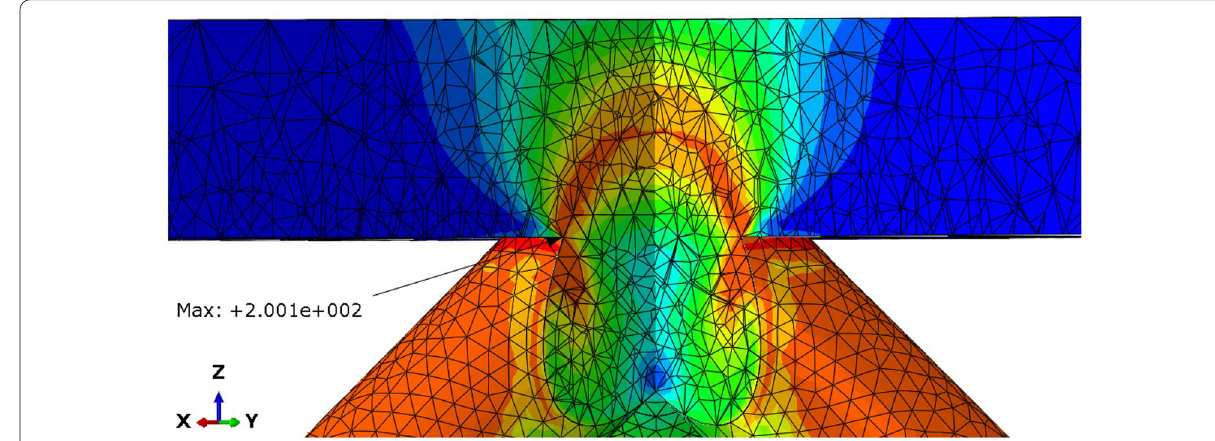
Figure 16 Section view at the middle joint